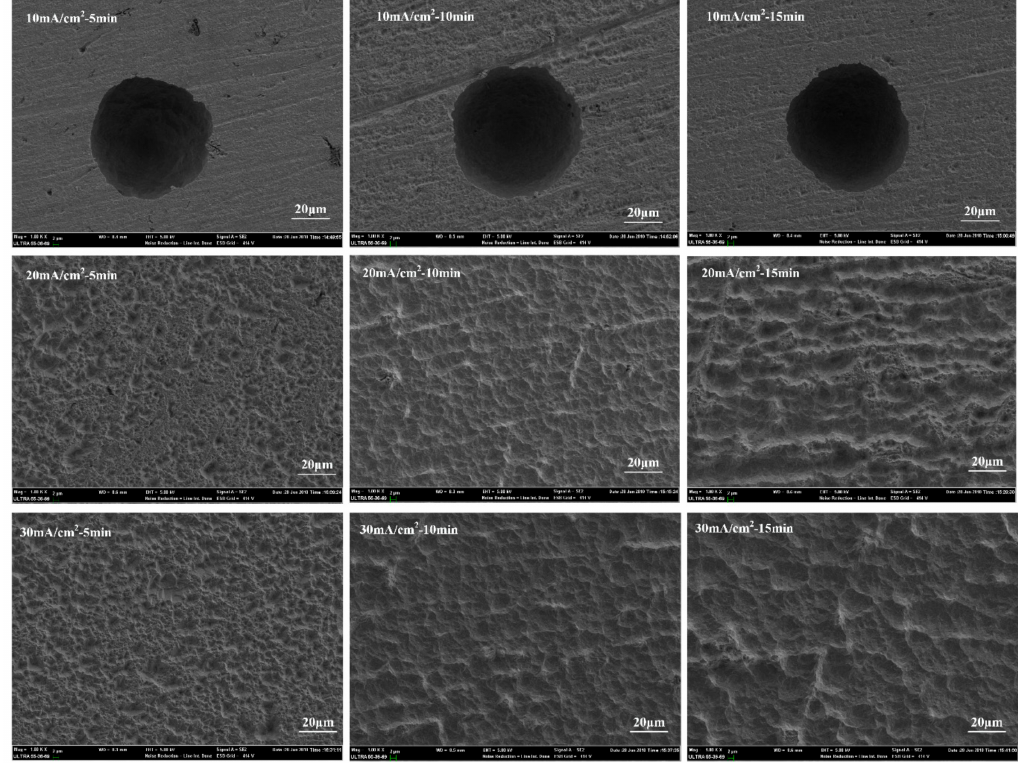
Figure 3. Surface morphology of the metal Ni films treated with different anodic current density and